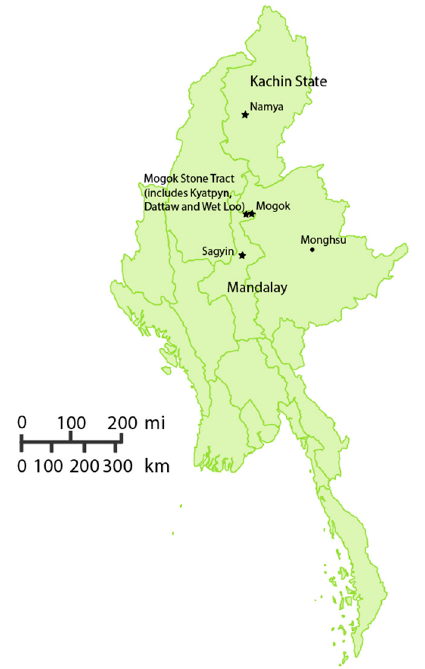
Figure 2. A political map showing Myanmar. Regions of origin for rubies analyzed in this study are marked by stars. Copyright © Free Vector Maps.com.